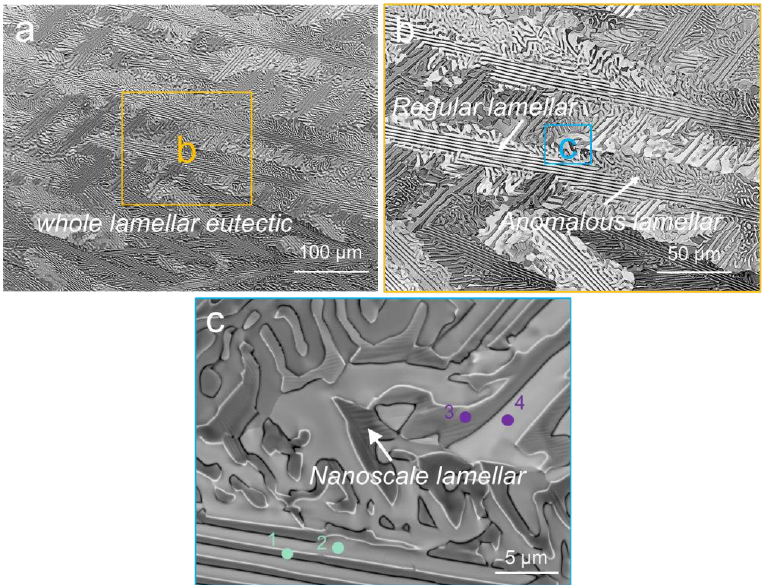
Figure 2. SEM images of the as-cast Co 39.2 Ni 39.2 Al 21.6 EMEA. ( a ) Low-magnification BSE image; ( b ) magnified BSE image in the solid orange box shown in (a); ( c ) high-magnification BSE image in the solid blue box shown in ( b ).